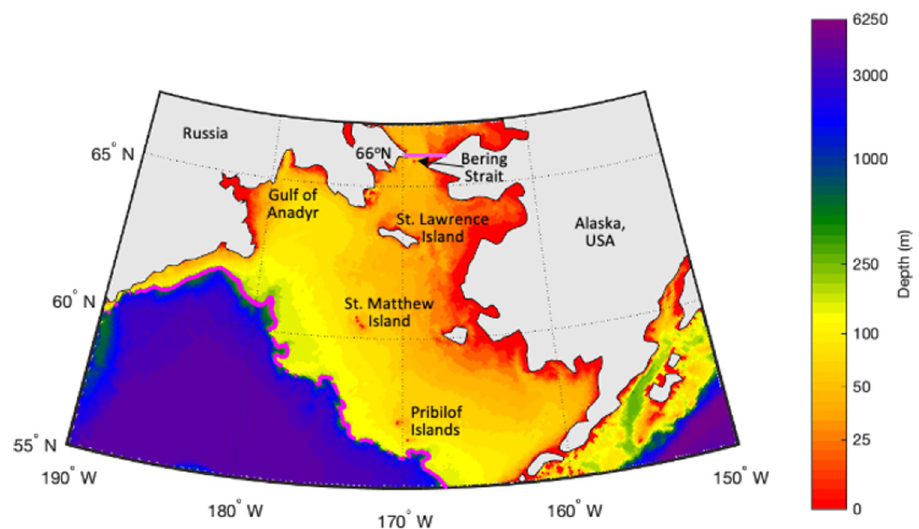
Fig 1. Bathymetry and region of interest. Bathymetry (m) of the Bering Sea, relevant place names, and the area for cold pool calculation (pink contours). Figure was created from the authors’ data.